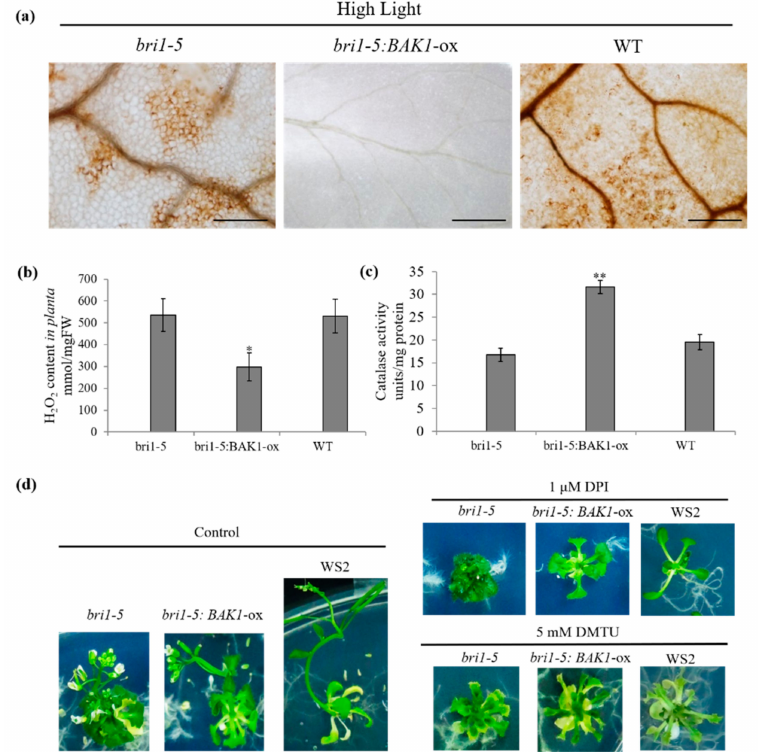
Figure 3. BAK1 overexpression plant under high light alleviates the H 2 O 2 level through enhancing catalase activities. ( a ) DAB-staining of rosette leaves of WT, bri1-5 , and bri1-5:BAK1-ox plants after high light treatment for 22 days. Bar = 200 µ m. The experiments were repeated three times with similar results. ( b , c ) Catalase activity and H 2 O 2 content in bri1-5 , and bri1-5:BAK1- ox plants’ leaves after high light treatment for 22 days. Error bars represent SD ( n = 4). The asterisks indicate significant di ff erences compared to the wild type (WT) plants (* p < 0.05, ** p < 0.01 by the Student’s t -test). The experiments were repeated three times. ( d ) Representative plants treated with diphenylene iodonium (DPI) or dimethylthiourea (DMTU) grown under 100 µ mol · m − 2 s − 1 light intensity. The 1 µ M DPI and 5 mM DMTU were added to the 1 / 2 MS medium and seedlings were photographed after 22-day’s growth. The experiments were repeated three times with similar